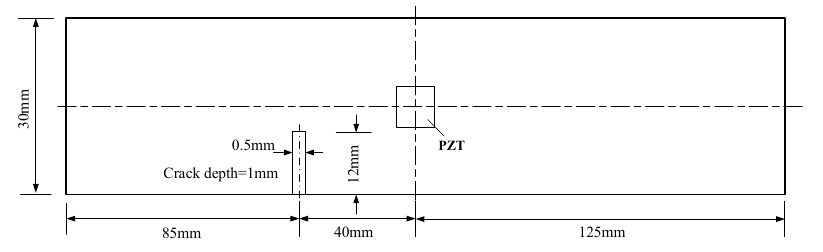
Figure 2. Schematic diagram of piezoelectric patch and crack location.